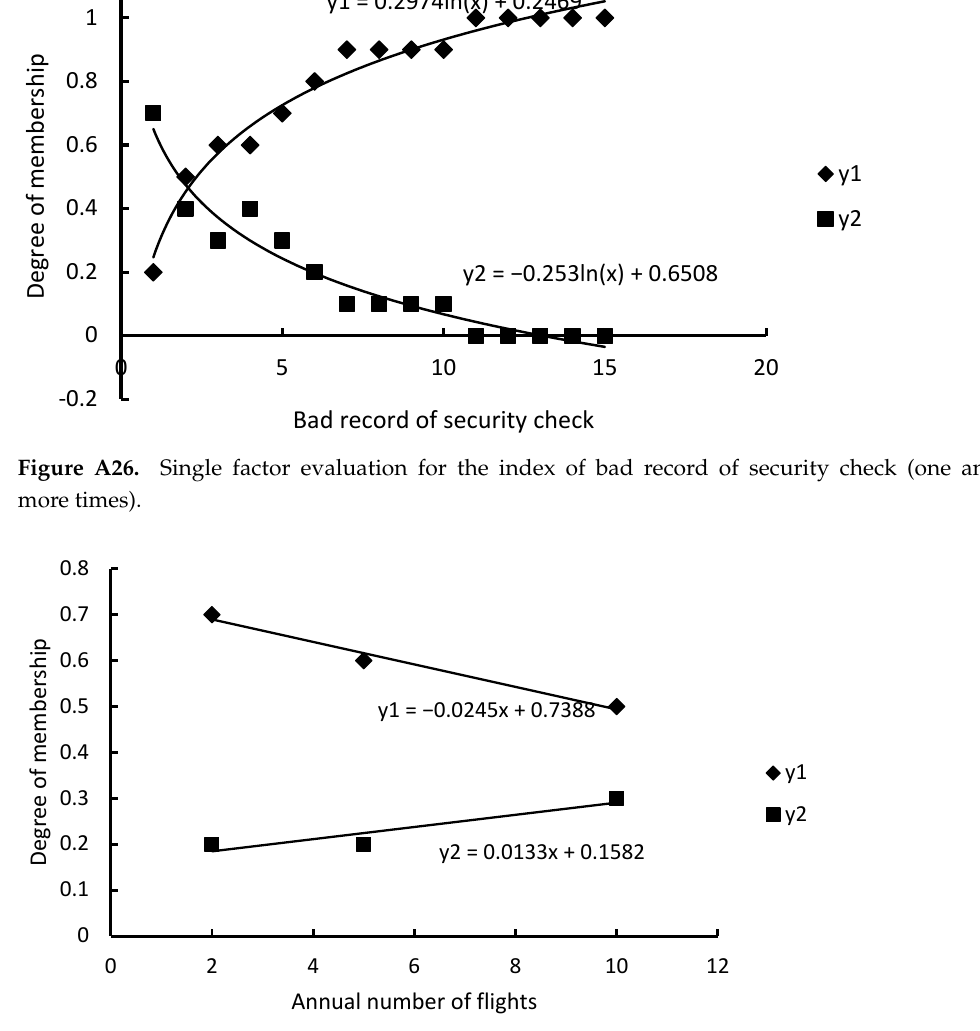
Figure A27. Single factor evaluation for the index of annual number of flights (0–10 times).